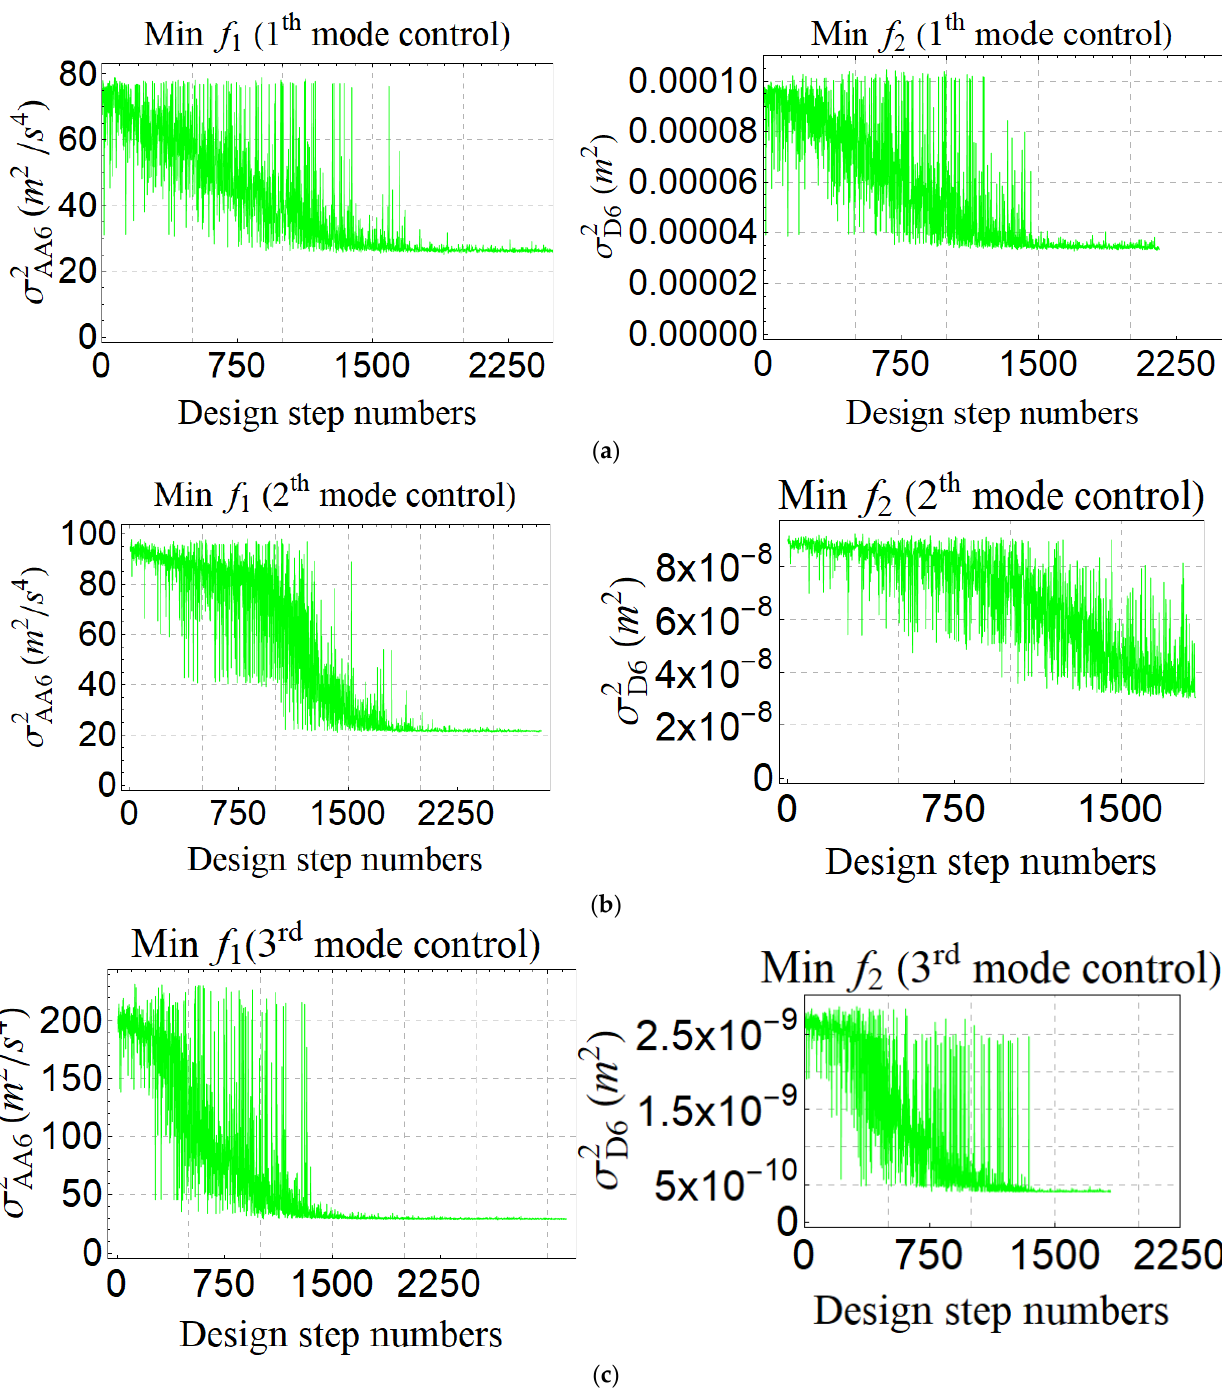
Figure 4. Variation in the transfer functions with respect to the design steps of the DE algorithm considering: ( a ) first, ( b ) second, and ( c ) third modes of the beam with respect to to 𝑓 (cid:2869) and 𝑓 (cid:2870) minimization.